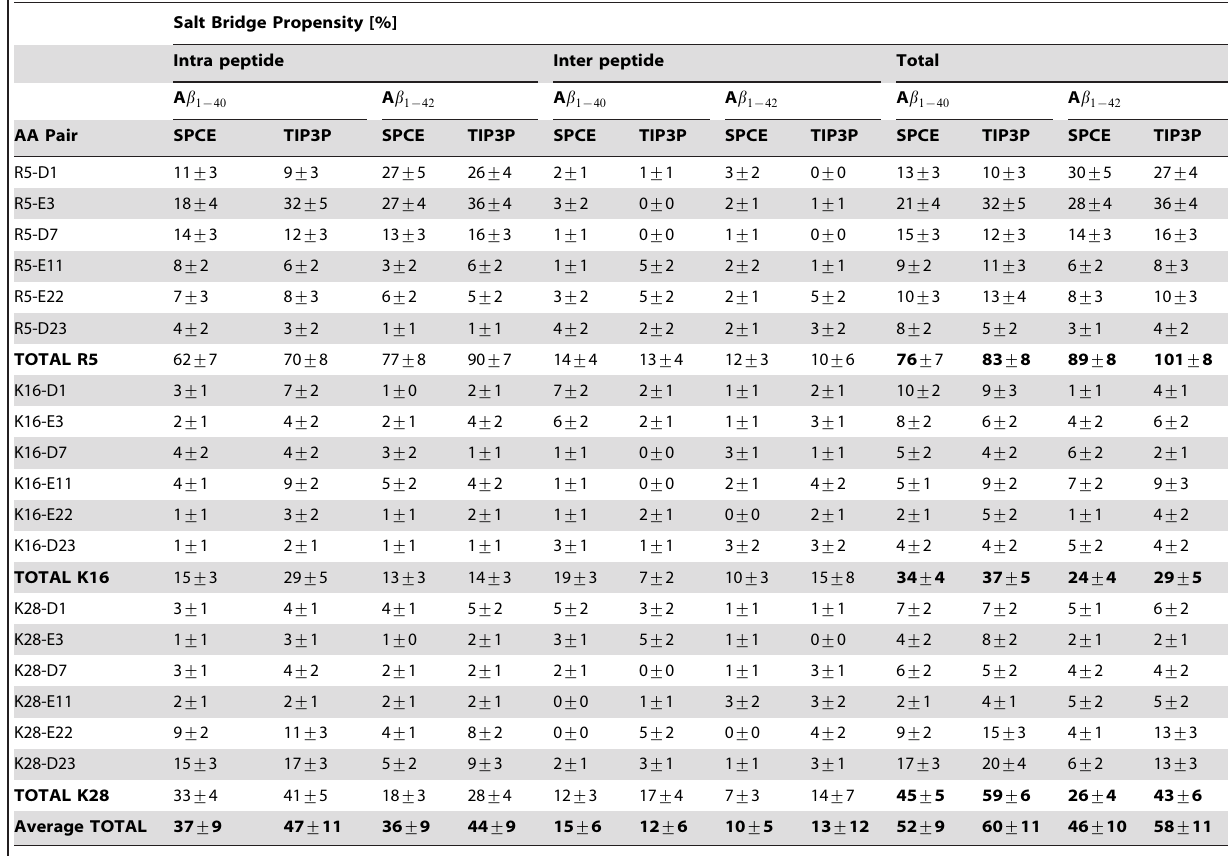
and A b 1 { 40 1 { 42